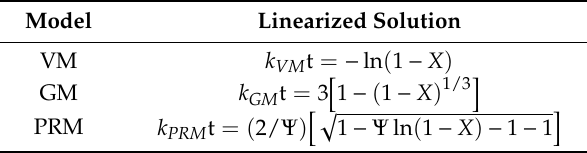
Table 6. The linearized solution of di ff erent